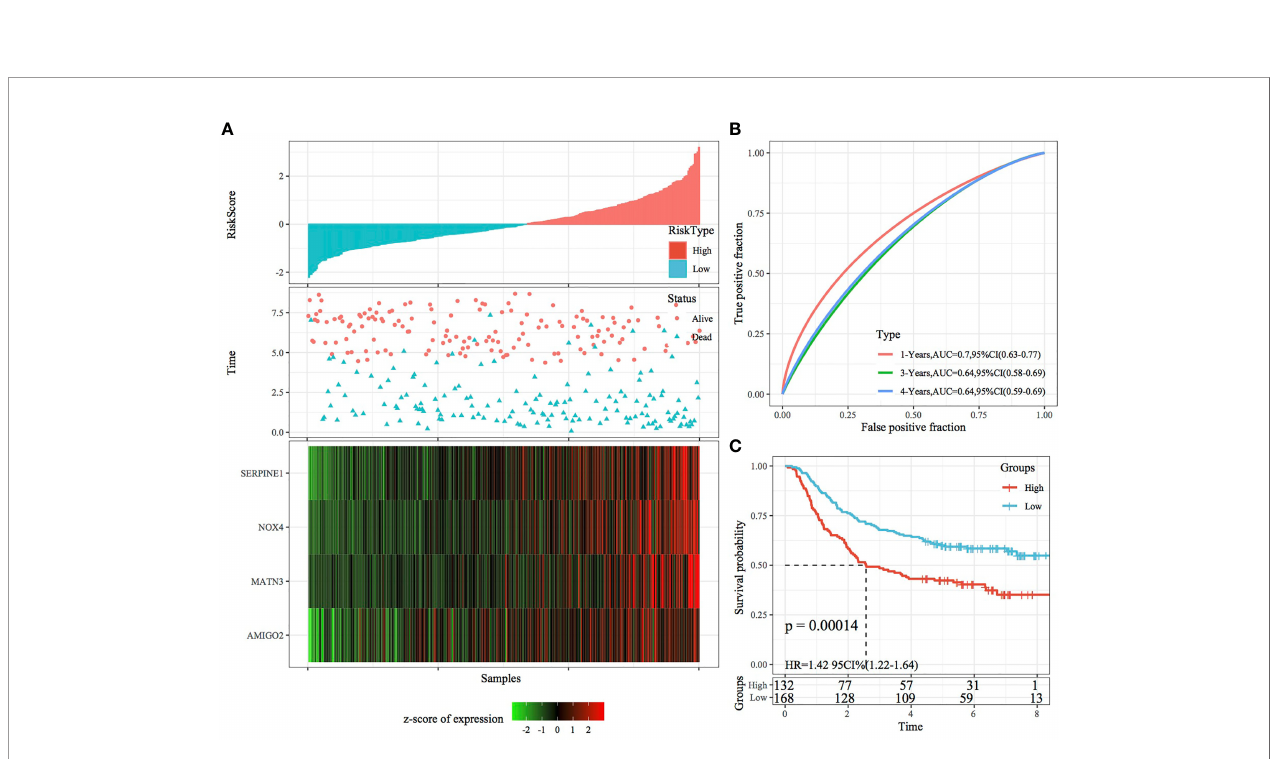
FIGURE 9 | Validation of the four-gene signature in the GSE66229 dataset. (A) RiskScore, survival status and the expression of four genes in the independent validation dataset GSE66229. (B) ROC curves and AUC of the four-gene signature. (C) KM curve demonstrating survival predicted by the four-gene signature in the independent validation dataset